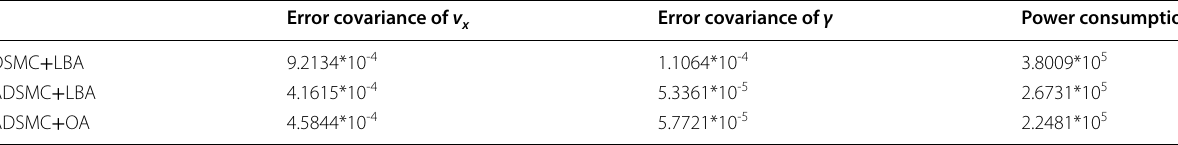
Table 2 Performances under different control strategies Error covariance of v